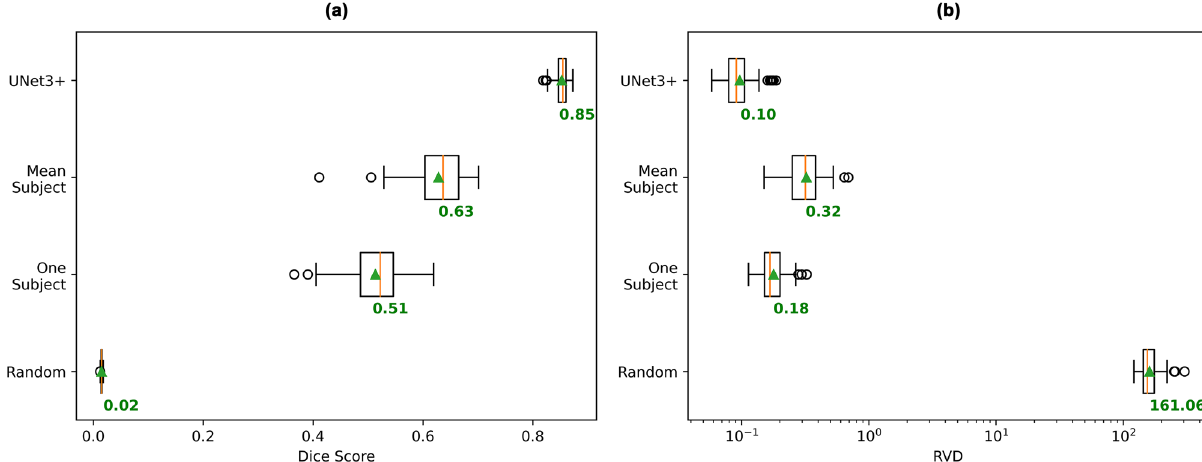
Figure 10. Performance comparison of various segmentation approaches. Box plots are computed on the ( a ) Dice scores (higher is better), and ( b ) RVD values (lower is better), across all 105 subjects, where the score for a subject is the mean across its 72 tract scores. Mean across all subject scores is indicated by green triangle and text. Orange bar indicates median score. ‘Random’ indicates a model that always generates a segmentation volume of uniform random data in the range [0,1] that is thresholded at 0.5. The ‘One Subject’ model takes the ground truth of a single subject and will always output that subject’s segmentation volume as the model output (voxels thresholded at 0.5). ’Mean Subject’ model will take the mean across all segmentation volumes in the training set and output it as the model output (voxels thresholded at